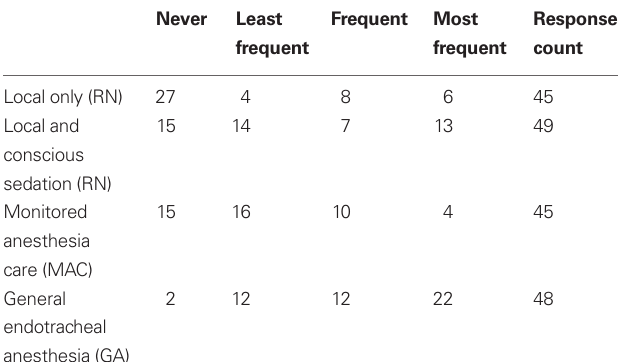
Table 1 | Anesthesia and analgesia preferences during endovascular ischemic stroke intervention.